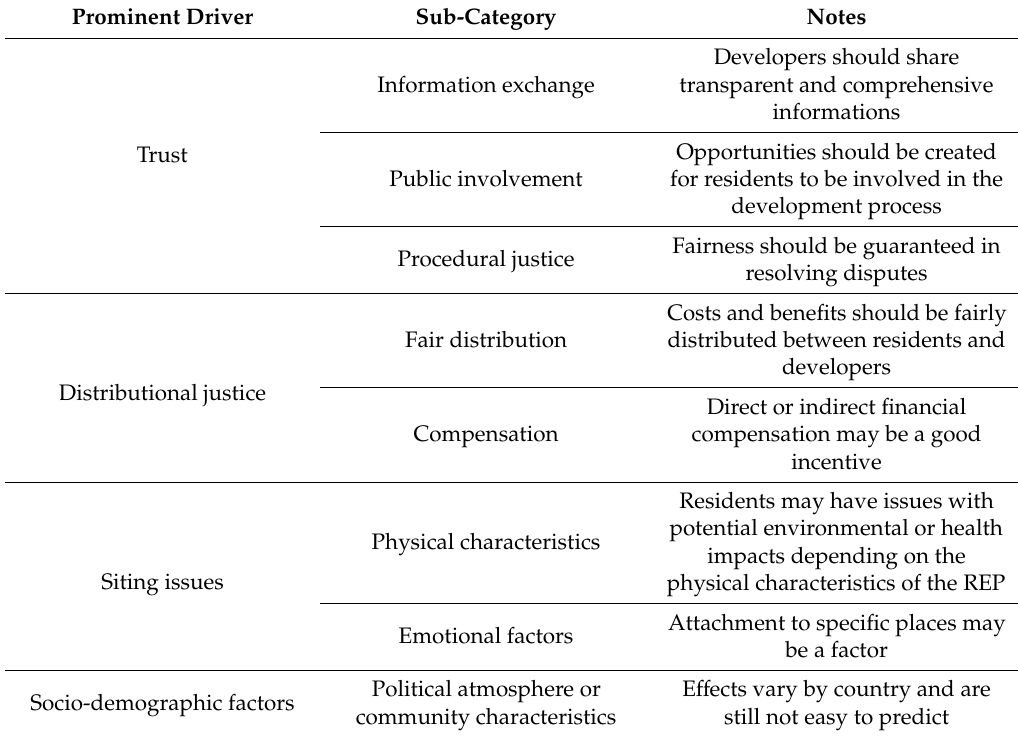
Table 6. Summary of the discussion on prominent